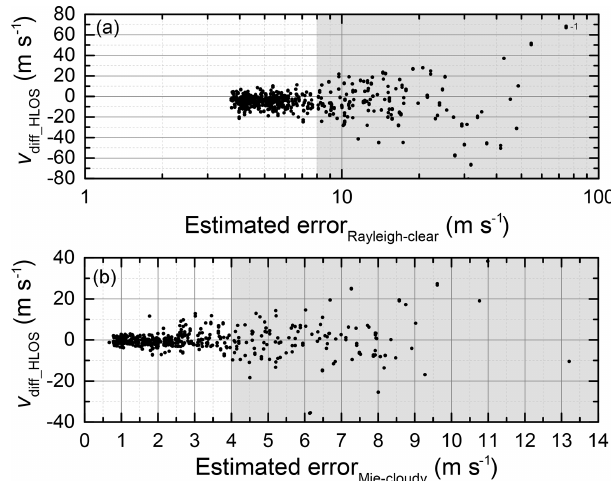
Figure 6. Wind speed difference of Aeolus HLOS winds and 2µm DWL winds projected onto the Aeolus viewing direction ac- cording to Eq. (2) depending on the estimated error given in the L2B product for Rayleigh-clear winds (a) and Mie-cloudy winds (b) . Shown are all valid data points from WindVal III and AVATARE. Data points with an estimated error larger than 8ms − 1 (Rayleigh) or 4ms − 1 (Mie) are not considered to be valid observations (gray